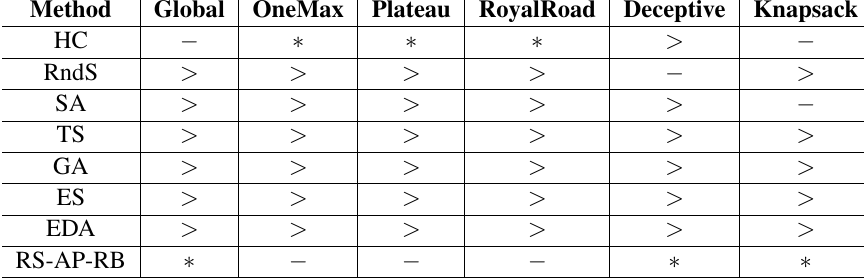
Table 6. Results returned by the Holm’s and Finner’s post-hoc tests at a significance level of α = 0 . 05 when the best learning scheme (RS-AP-RB) and the individual metaheuristics are compared globally and on each specific problem. The symbol ‘*’ indicates the learning scheme considered as control method (the method with the best mean ranking); ‘ > ’ means that the control method improves sig- nificantly the corresponding learning scheme; and ‘-’ indicates no significant differences between the two learning schemes. In case both tests do not provide the same result (e.g., Holm’s test does not rejects the hull hypothesis and Finner’s does), Finner’s post-hoc test result is displayed within